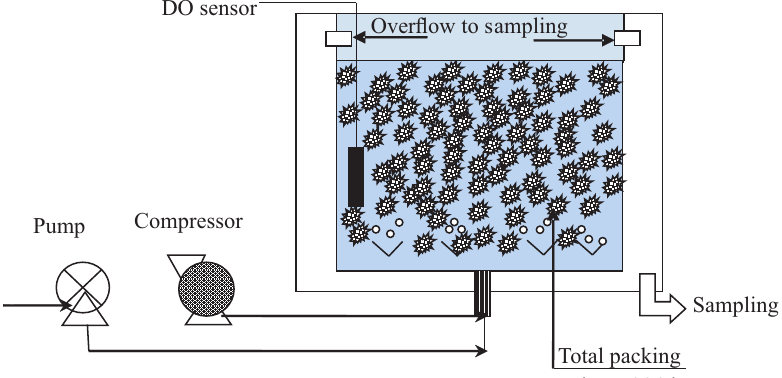
Figure 1. Schematic of reactor setup